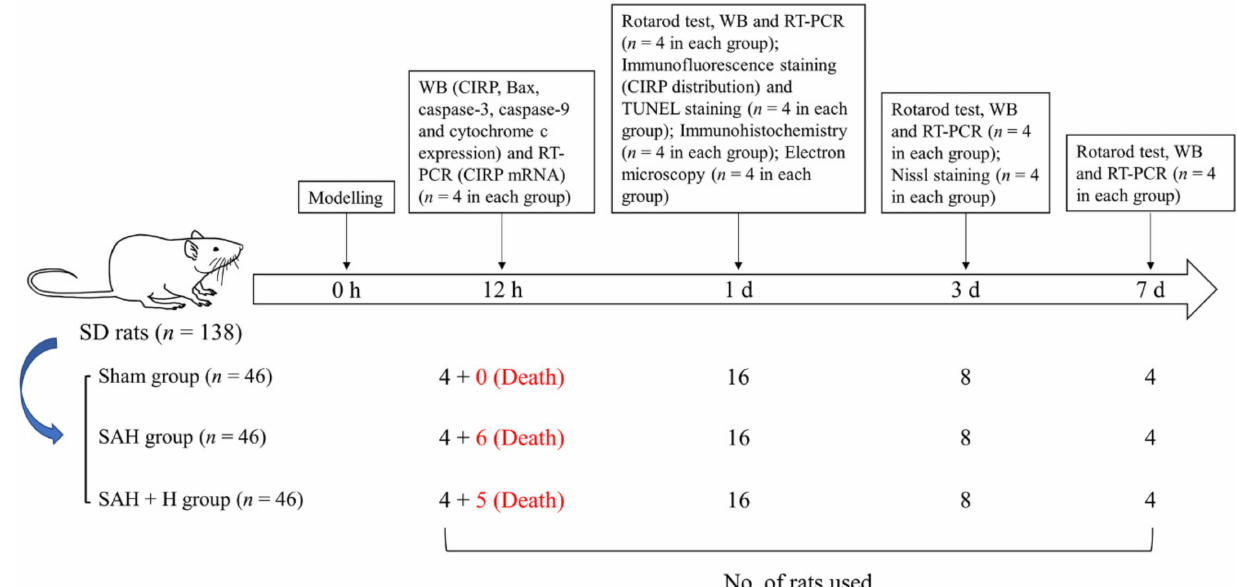
Figure 1. The schematic illustration of the experimental